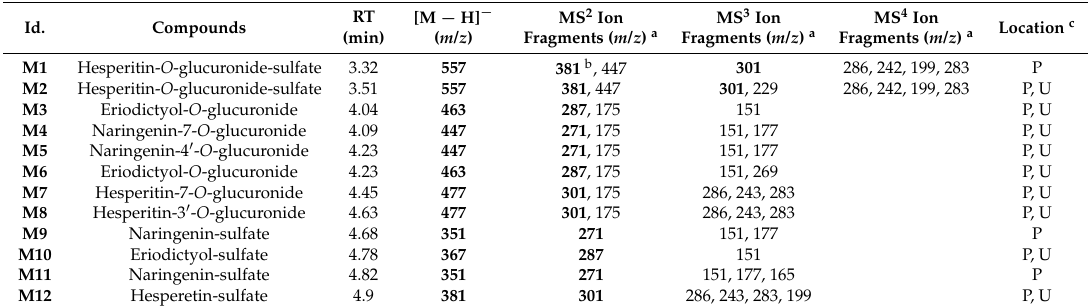
Table 2. Flavanone metabolites in plasma and urine collected after consumption of bergamot juice (BJ).